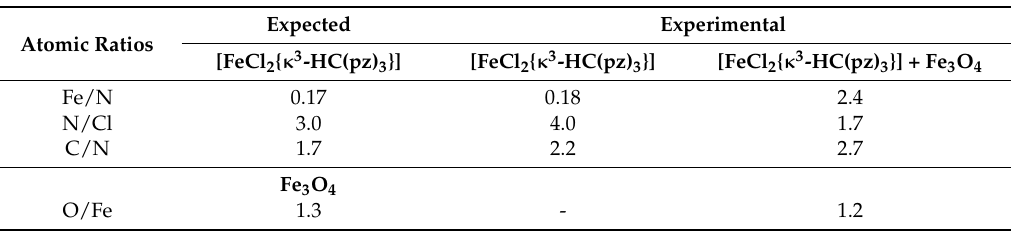
Table 1. Experimental XPS atomic ratios and expected ratios for [FeCl 2 { κ 3 -HC(pz) 3 }] ( 1 ), Fe 3 O 4 and their (1:1) mixture ( 2 ).